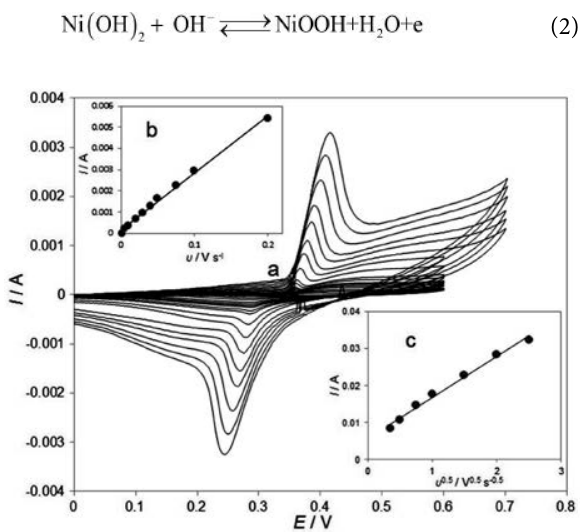
Figure 3. (a) Typical cyclic voltammograms of Ni-Cu electrode in 1 M NaOH at different scan rates of 2–2500 mV s –1 , (b) The depend- ency of anodic peak currents to the scan rate at lower values (2–200 mV s –1 ), (c) The proportionality of anodic peak currents to the square roots of scan rate at higher values (350–2500 mV s –1 ).